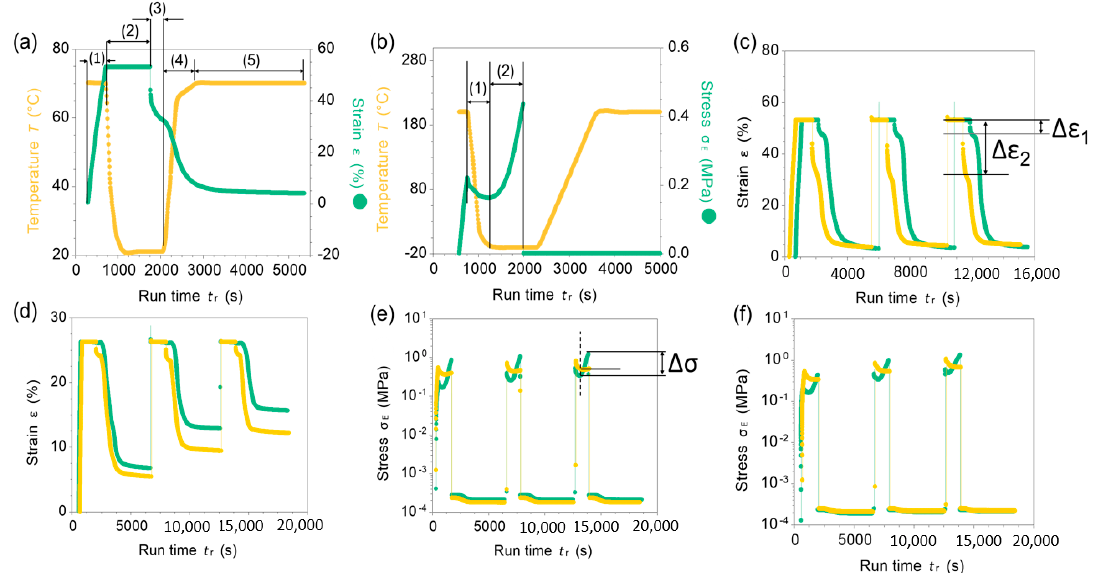
Figure 7. ( a ) An example of a programming process, including (1) material deformation by stretching at a strain rate of 10% / min at 70 ◦ C, (2) fixing process at the selective strain by cooling down to 20 ◦ C, (3) removing the applied stress at the fixing temperature (20 ◦ C), (4) increasing the temperature to 70 ◦ C without the applied stress, (5) keeping isothermally at 70 ◦ C without the applied stress to recover the original dimension. ( b ) An example of a stress profile during the programming process: (1) the applied stress after stretching under cooling process and (2) increasing stress during the fixing process indicating low stress fixity and stability of the studied material. ( c ) Strain recovery after multiple deformation of NBR-S lignin (green profile) and NBR-I lignin (yellow profile) at 70 ◦ C; ∆ ε is the strain loss during fixing process ( d ) Strain recovery after multiple deformation of NBR-S lignin (green) and NBR-I lignin (yellow) at 200 ◦ C. ( e , f ) Stress profile of the two studied samples during programming process at two selected temperatures, 150 and 200 ◦ C, respectively ( ∆ σ the stress increase during fixing). NBR-S lignin is green, NBR-I lignin is